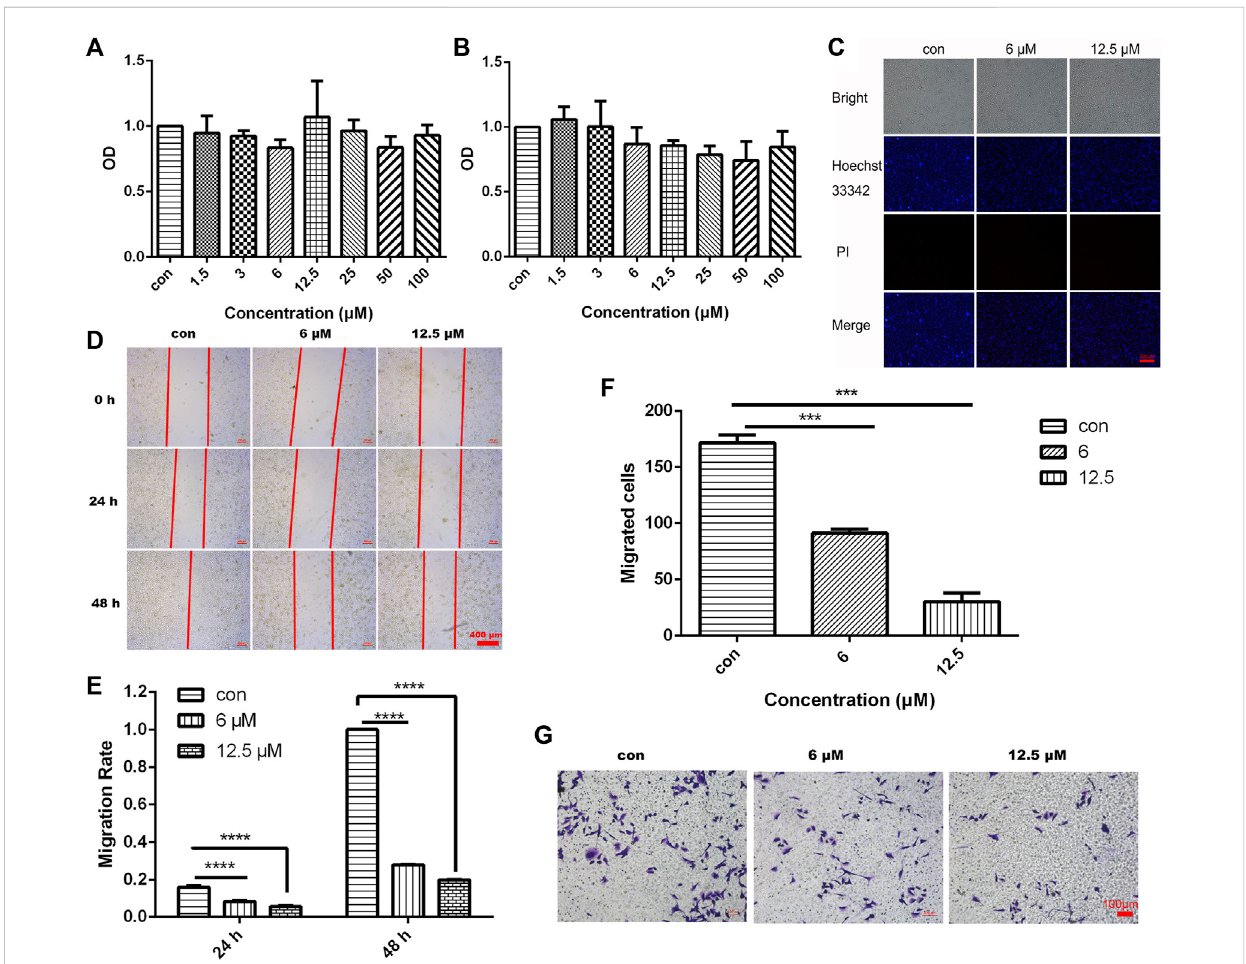
FIGURE 4 JZTX-14hadnoeffectontheproliferationofMDA-MB-231cellsbutinhibitedcellmigrationandinvasion. (A,B) MDA-MB-231cellsweretreatedwith different concentration gradients of JZTX-14 for 24 and 48 h, and cell viability was assessed using CCK-8 assay. (C) JZTX-14 (0, 6, and 12.5 μ M) had no signi fi canteffectonthenecrosisofMDA-MB-231celllinesasanalyzedusingHoechst33,342andPIstaining;PI(red)fornecroticcellnuclearstainingand Hoechst33,342 (blue) for nuclear staining. Barcodes represent 200 μ m; (D,E) Representative imagesand statisticalanalysisof MDA-MB-231 cells in thewound healing assay after treatment with JZTX-14 (0,6, and 12.5 μ M). (F,G) Representative images and statisticalanalysis ofMDA-MB-231 cells using transwell assay after treatment with JZTX-14 (0, 6, and 12.5 μ M).